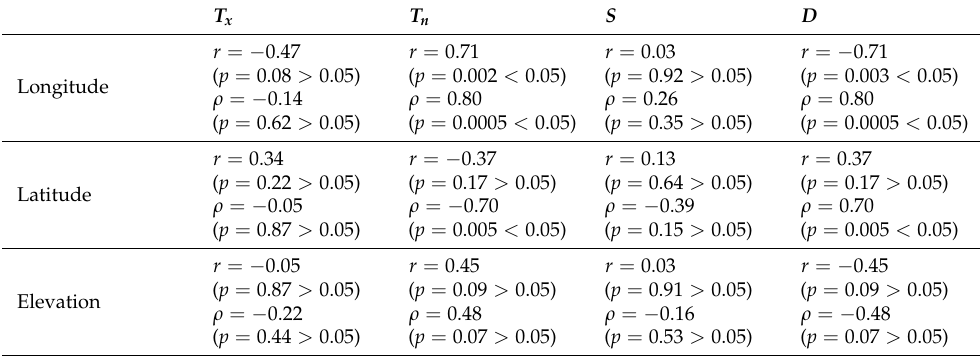
Table 2. Correlations (Pearson’s r and Spearman’s ρ ) of impacts of maximal and minimal temperature— T x and T n , solar radiation S , day length D , with geographical characteristics of collection